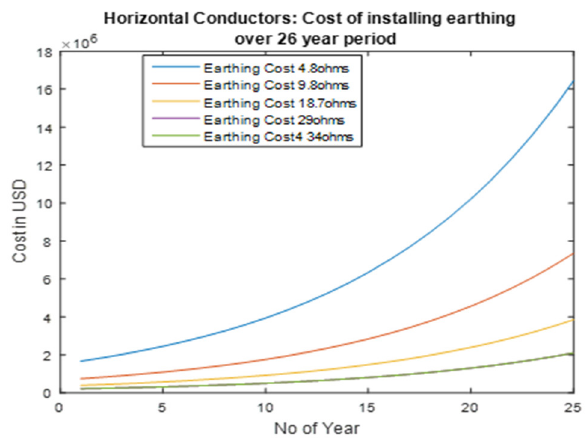
Figure 10. Cost of installing an earthing system.